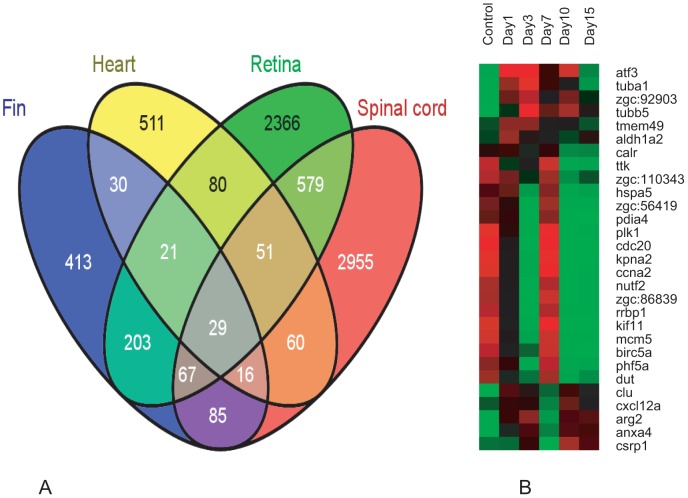
Common genes differentially expressed in spinal cord, fin, retina and heart during regeneration in zebrafish.A) Vein diagram illustrates number of genes that are expressed (uniquely as well as shared) during regeneration of the four different tissues like fin, heart, retina and spinal cord. B) Differential expression pattern of the 29 common genes in uninjured and injured zebrafish spinal cord with different time points. The color chart indicates mean fold change of gene expression in each time points. Red and green color represents increased and decreased expression respectively.